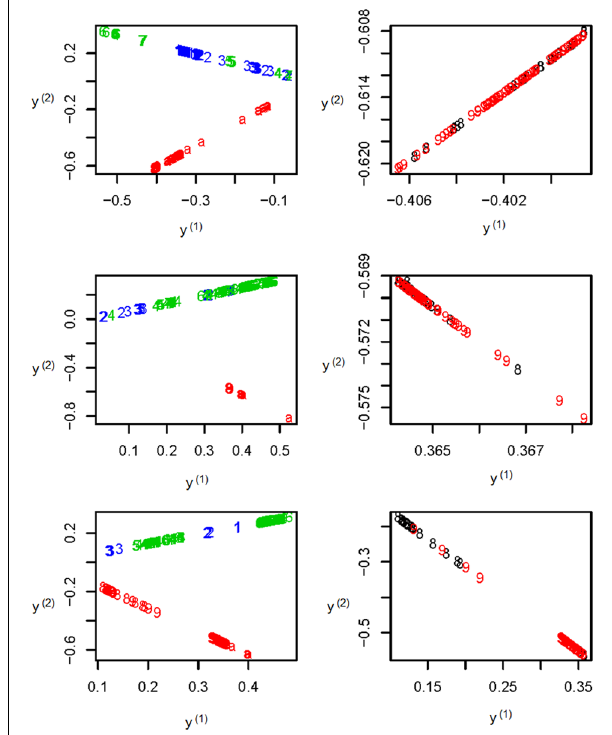
FIGURE 3 | The top two sub-figures are for the unsupervised local scale spectral clustering algorithm, the middle two are for SSSC algorithm ( α = 0 , β = 1 ) and the bottom two are for our SSSC algorithm ( α = ˆ α , β = ˆ β ). Note that in the right three sub-figures, the colors of the subjects in CHS (‘8’) were changed from red to black. Note that the y ( 1 ) and y ( 2 ) axes are just the first two co-ordinates of the data points { y 1 ,..., y n } in Step 6 of AlgorithmSSSC